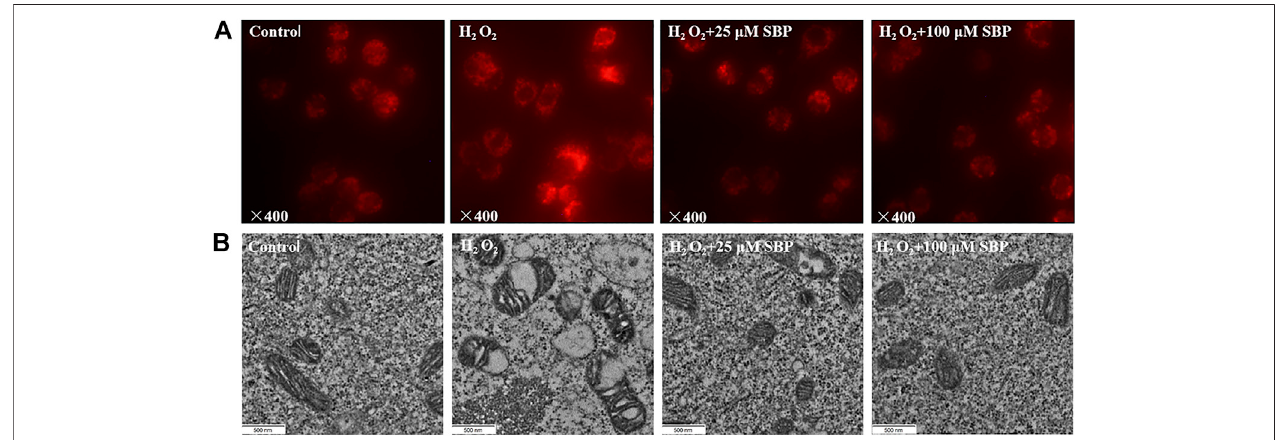
FIGURE 2 | Effects of SBP on morphology of mitochondrial of RAW 264.7 cells. (A) : Representative images show morphology of mitochondria. Mitochondrial morphology was visualized after staining the cells with MitoTracker Red and images were captured under fl uorescence microscope; (B) : Transmission-electron- microscopy (TEM) images of mitochondria in RAW 264.7 cells (×21,000).